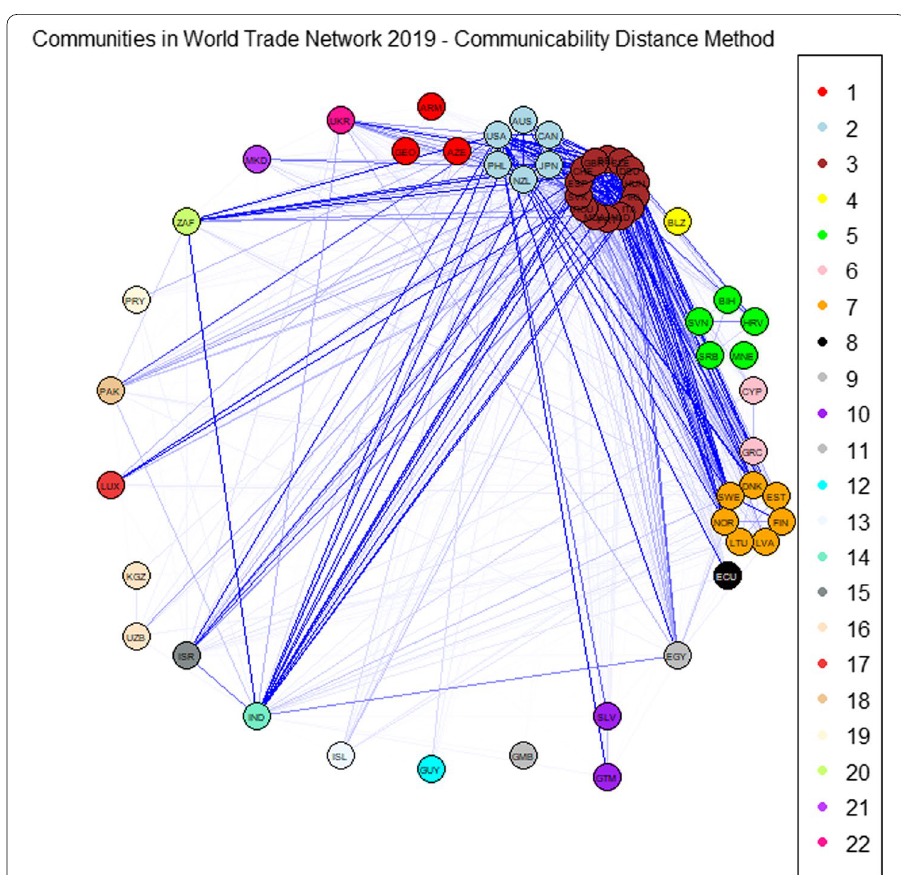
Fig. 1 Community graph obtained with the communicability distance method in 2019